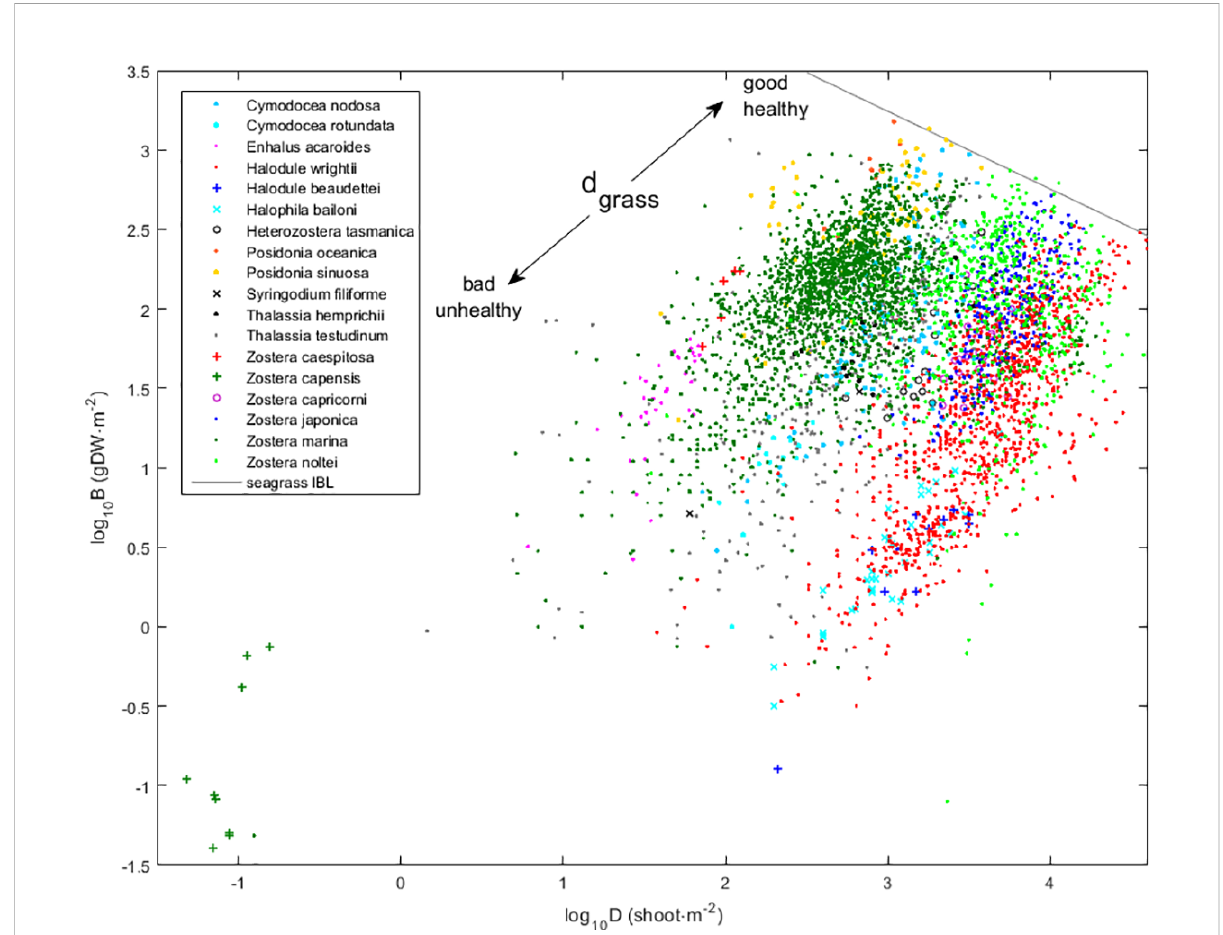
FIGURE 2 The meta-analysis on the biomass – density relations of 18 seagrass species and the derived seagrass IBL. B, biomass in grams of dry weight (g DW) per square meter; D, density of shoots per square